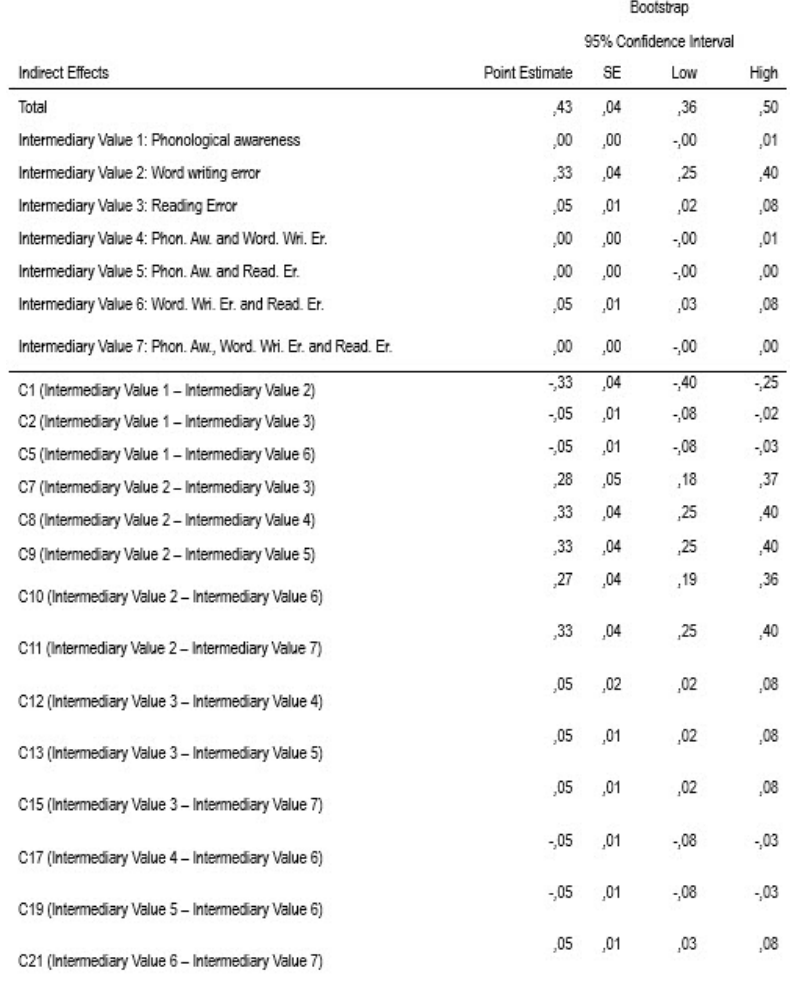
Indirect effects and specific indirect effects of visual perception on phonological awareness, word writing error, reading error, and sentence writing